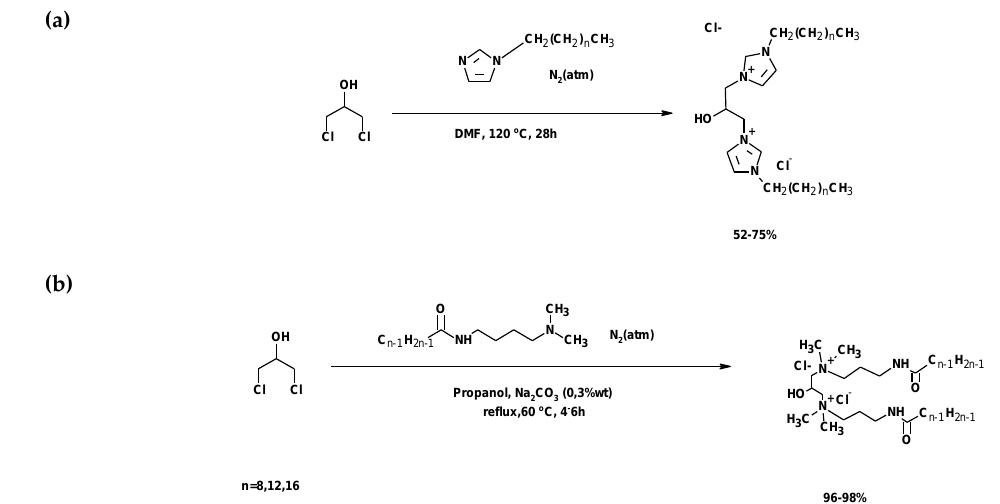
Figure 30. ( a ) Synthesis of gemini imidazolium salts using 1,3-DCH. ( b ) Synthesis of lineal amide-based gemini cationic surfactants using 1,3-DCH.